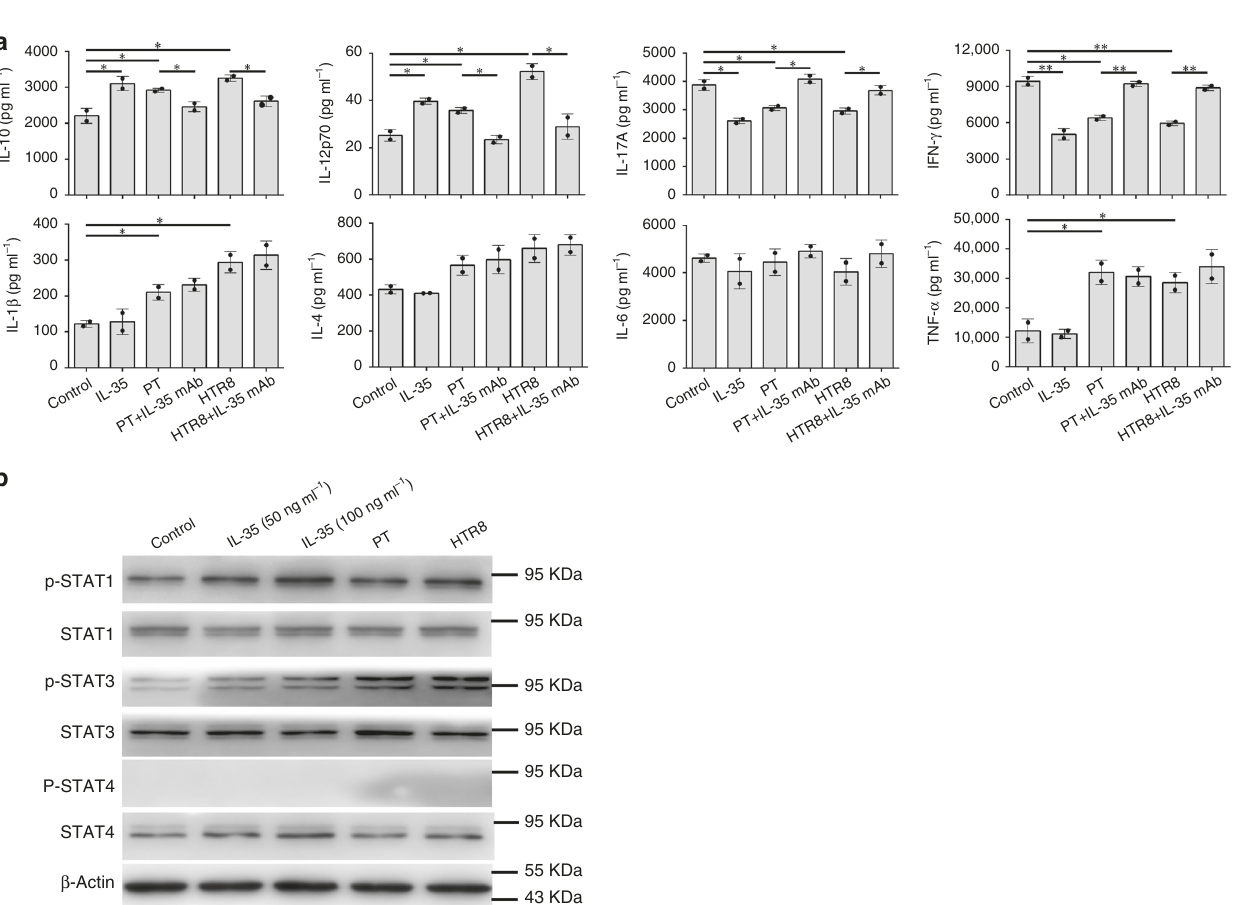
Fig. 4 Cytokines secretion pro fi le evaluation of T conv cells induced by trophoblast cells-derived IL-35 and the related transcription factors which mediate the conversion. a T conv cells were cultured in medium (control) alone, or with human r-sc-IL-35 (IL-35) (50 ng ml − 1 ), or with trophoblast cells supernatant (with or without neutralizing anti-IL-35 mAb) for 5 days. Then the supernatants of activated T conv cells were collected for cytokines secretion pro fi le evaluation using Bio-Plex Protein Array system. In T conv cells co-cultured with supernatant from PT or HTR8 cells, fi nal results of cytokines concentration were normalized to the initial supernatant from PT or HTR8 cells, respectively, which were used as inner control ( n = 2). b T conv cells were cultured in medium (control), or with human r-sc-IL-35 (IL-35) (50 ng ml − 1 or 100 ng ml − 1 ), or with trophoblast cells (PT and HTR8) supernatant for 1 h. Then, T conv cells were collected and the protein levels of phosphorylated (p) and total STAT1, STAT3, and STAT4 were determined by western blot ( n = 3). Data were represented as mean ± SD. Signi fi cance was determined by Student ’ s t -test. * P < 0.05 and ** P < a successful pregnancy and IL-35 may represent a valid immu- notherapeutic strategy for the treatment of recurrent spontaneous abortions.